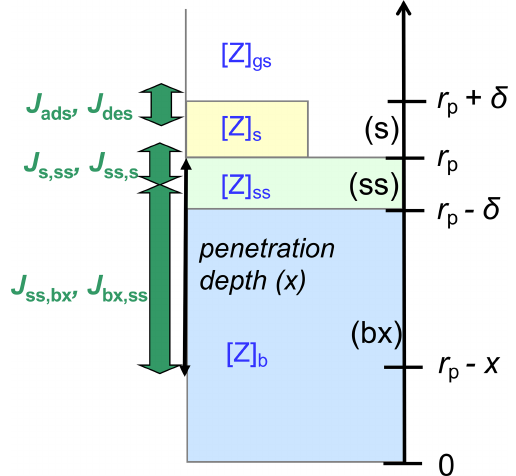
Figure A1. Schematic illustration of the kinetic multilayer model- ing approach resolving mass-transport fluxes ( J ) between the near- surface gas phase (gs), the sorption layer (s), the quasi-static surface layer (ss), and the bulk layer at penetration depth x (bx) (Shiraiwa et al.,